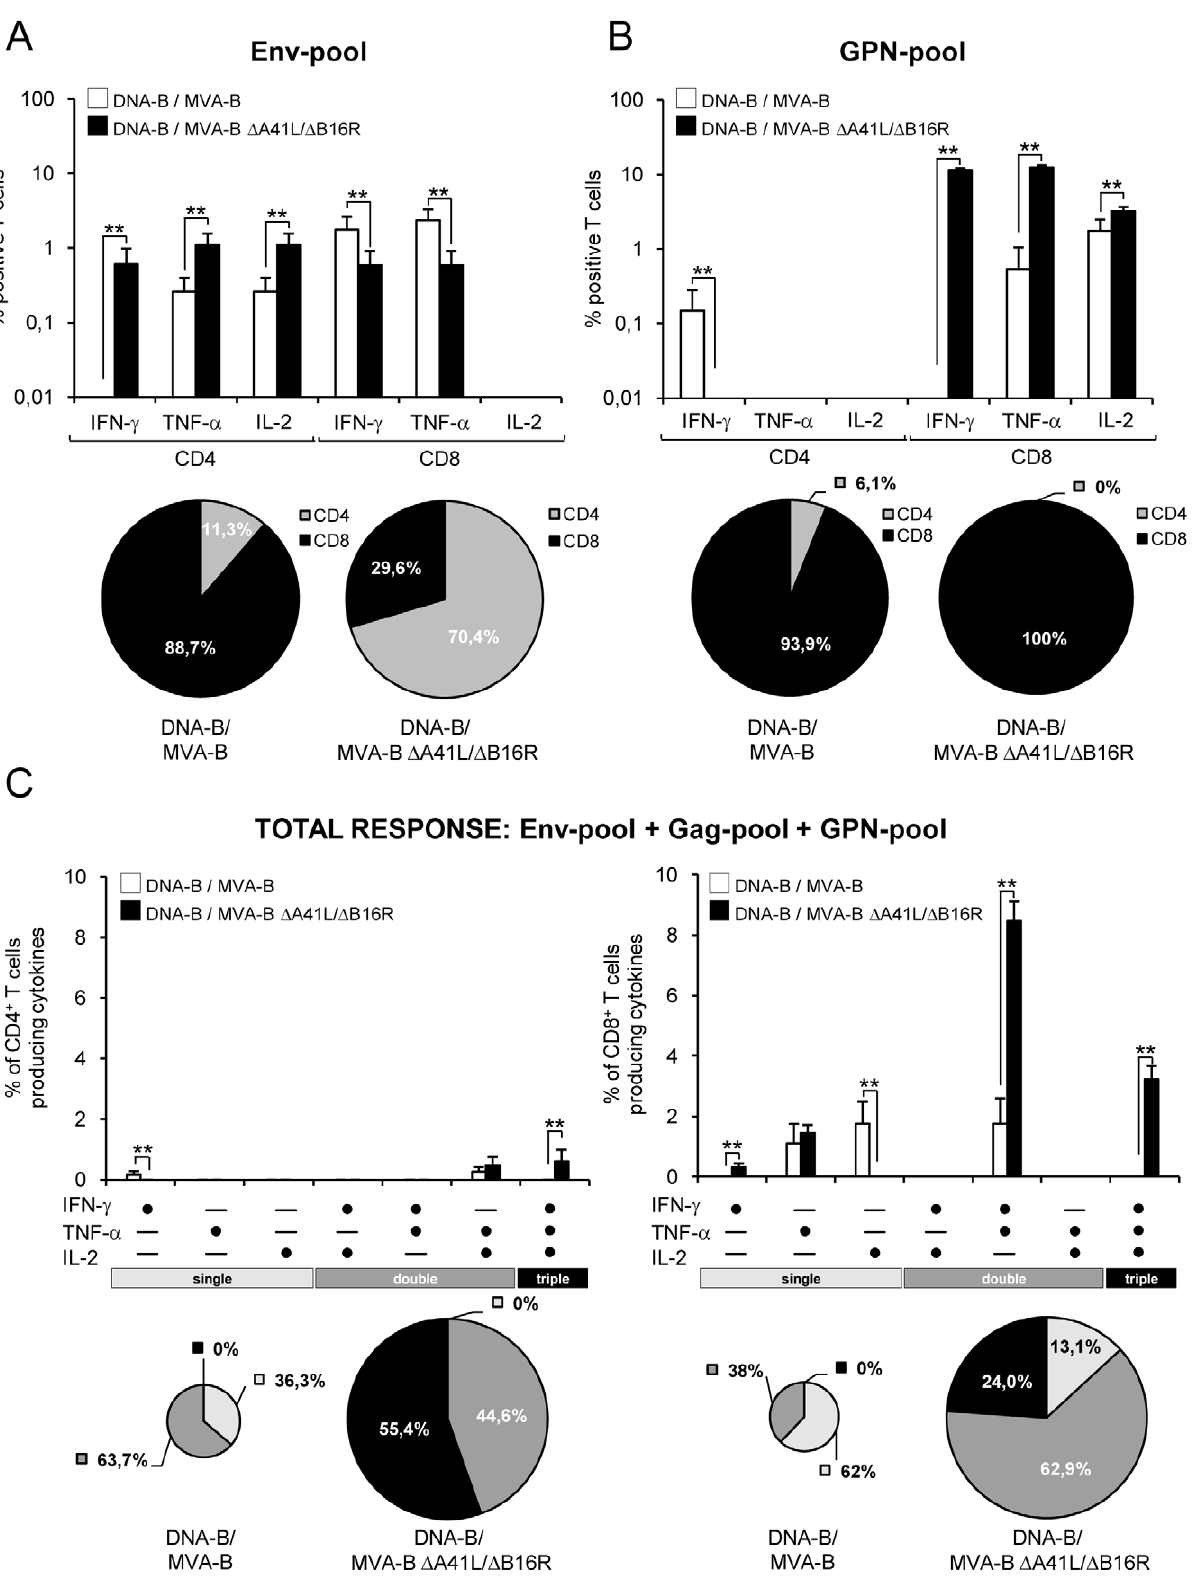
Figure 3. Cytokine secretion and polyfunctionality of HIV-1-specific CD4 + and CD8 + T cells after 11 days post-boost with MVA-B and MVA-B D A41L/ D B16R. Mice were infected and splenocytes processed as described in Figure 2. (A and B) Percentages of CD4 + and CD8 + T cells secreting IFN- c , TNF- a or IL-2, and directed against HIV-1 peptide pools Env-pool (A), and GPN-pool (B), and measured by ICS. The background of the unstimulated controls was subtracted in all cases, and only significant values over the background are represented. Standard deviations are shown.